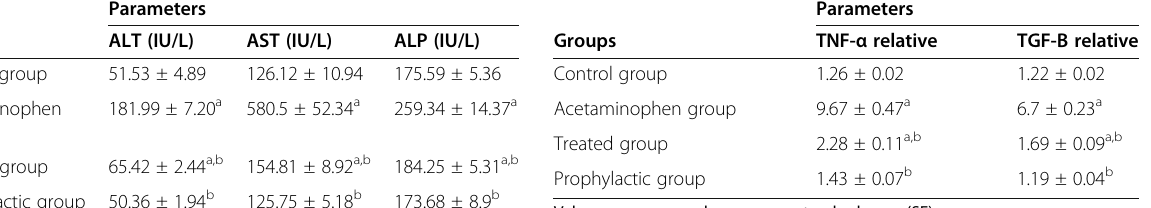
Table 5 Mean levels of TNF- α and TGF- β gene expression in the different studied groups